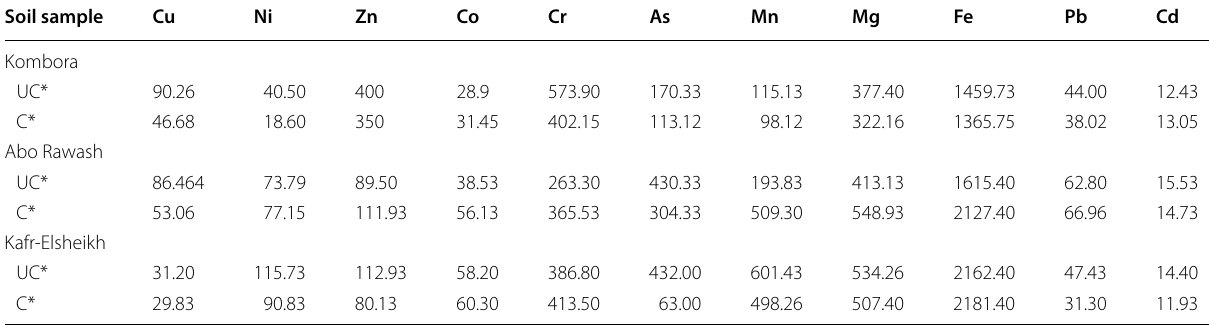
UC uncultivated soil, C cultivated soil